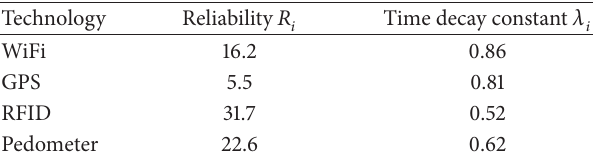
Table 3: Optimized system parameters.